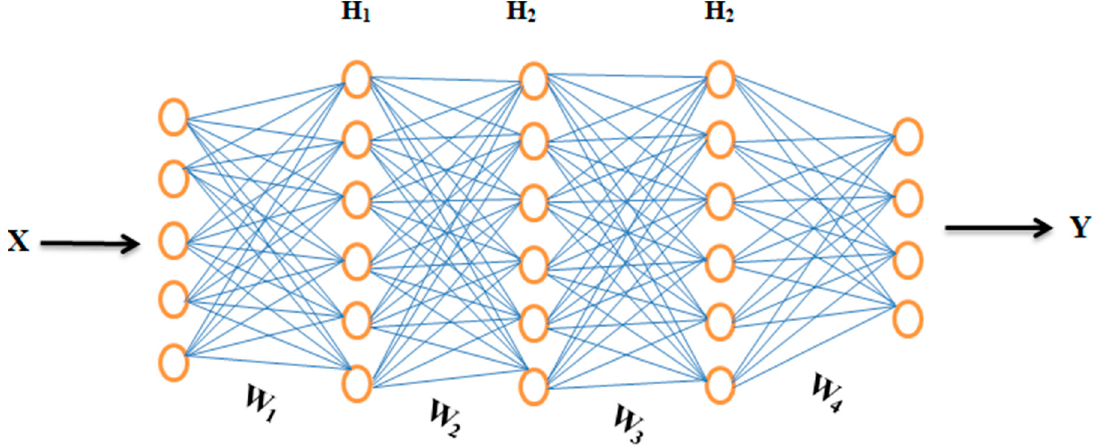
Figure 5. Represents a simple NN of one input layer, three hidden layers, and one output layer.